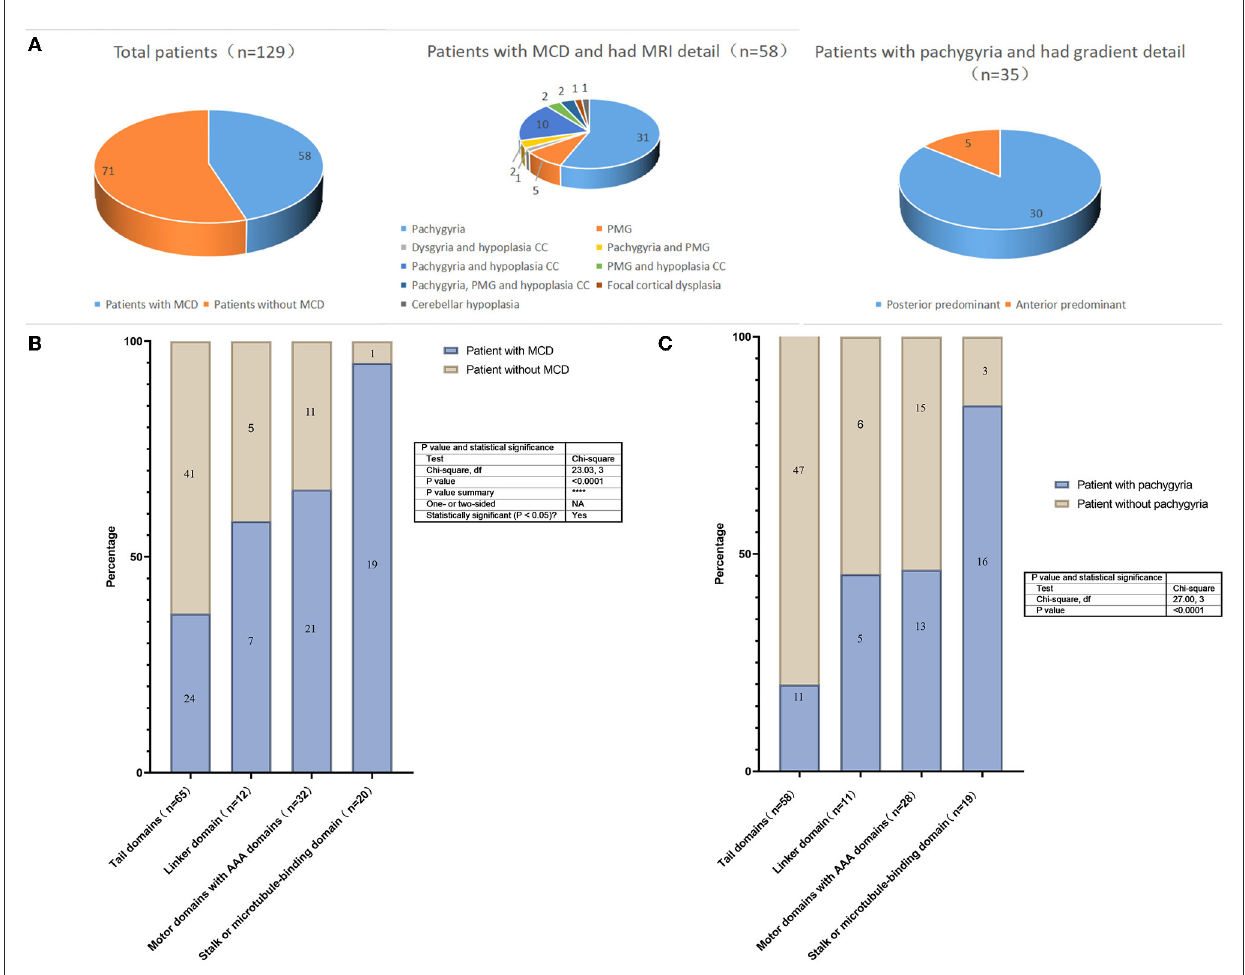
FIGURE3 (A) The proportion of malformations of cortical development and subtype in the patients with DYNC1H1 mutations; (B) Prevalence of MCD. Prevalence of different variants in the 4 domains of the DYNC1H1 protein; (C) Prevalence of pachygyria. Prevalence of different variants in the 4 domains of the DYNC1H1 protein. PMG, polymicrogyria; CC, corpus